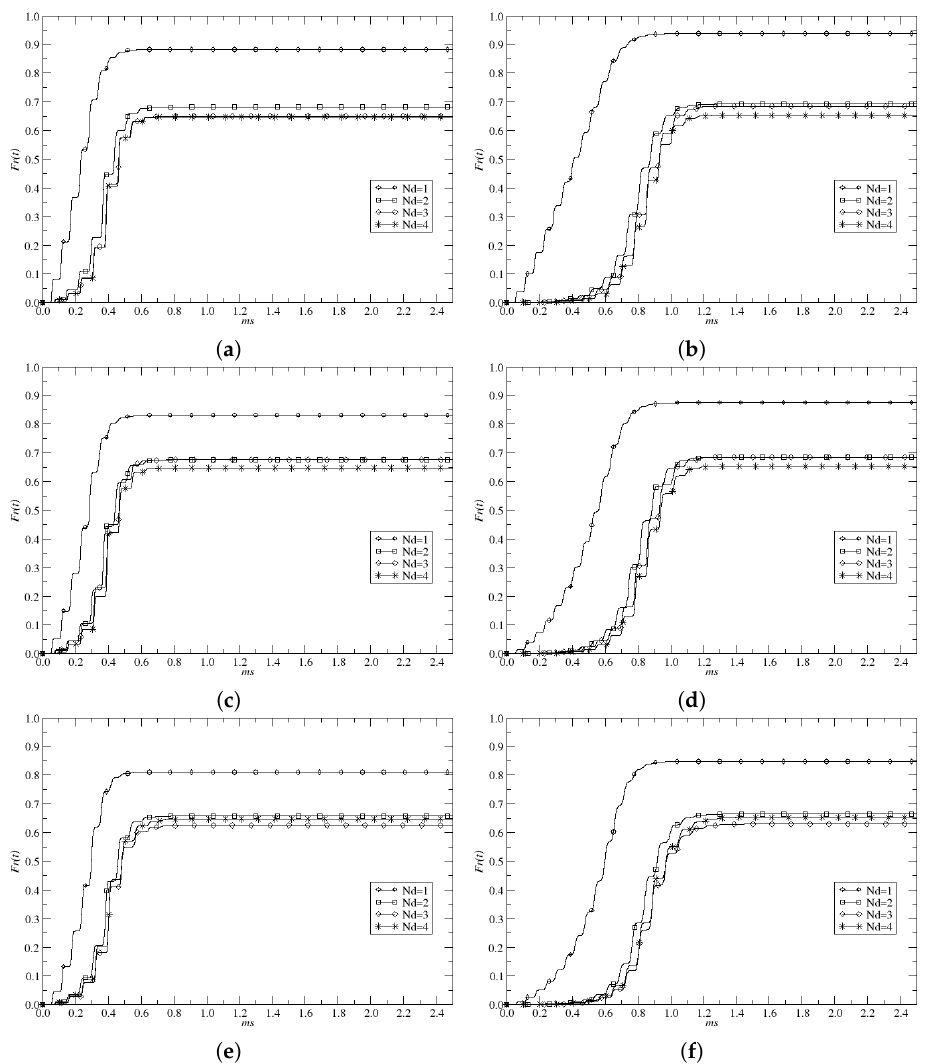
Figure 9. Service time of the secondary user using a queue size of 5 ( left column ) and 10 ( right column ) IUs. ( a ) Wl = 0.3, QS = 5. ( b ) Wl = 0.3, QS = 10. ( c ) Wl = 1.0, QS = 5. ( d ) Wl = 1.0, QS = 10. ( e ) Wl = 3.0, QS = 5. ( f ) Wl = 3.0, QS = 10.